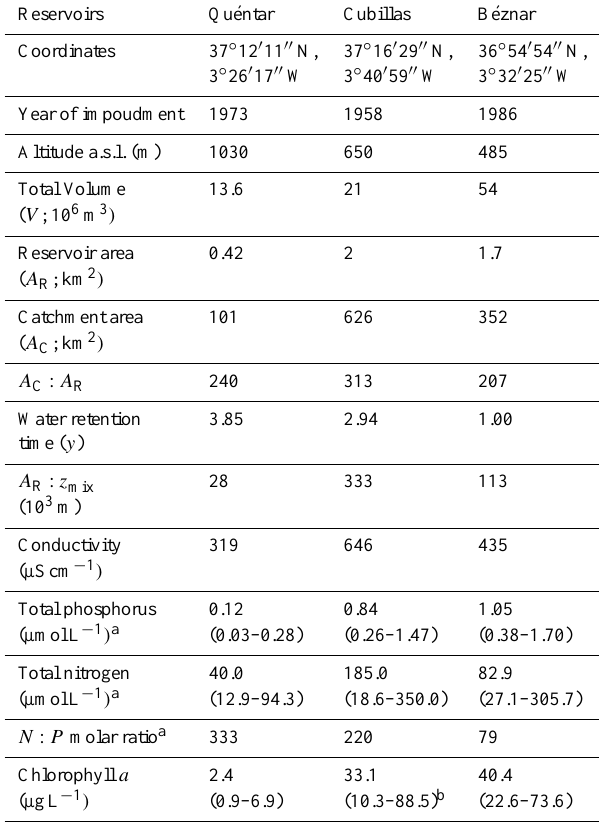
Table 1. Location and general physical, chemical and biological features of the study reservoirs. Z mix is the mixing water depth (6m in Cubillas and 15m in Qu´entar and B´eznar). Modified from de Vicente et al.